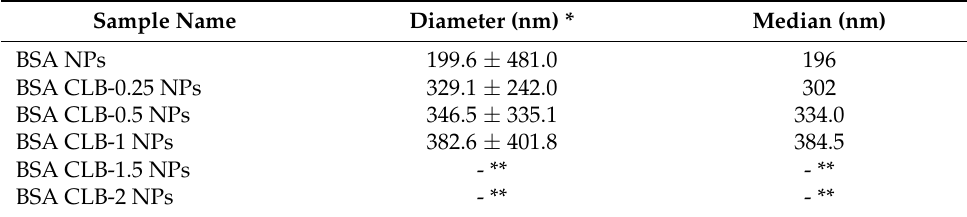
Table 3. Nanoparticle diameter and median. ( n = 200; average ± RSD